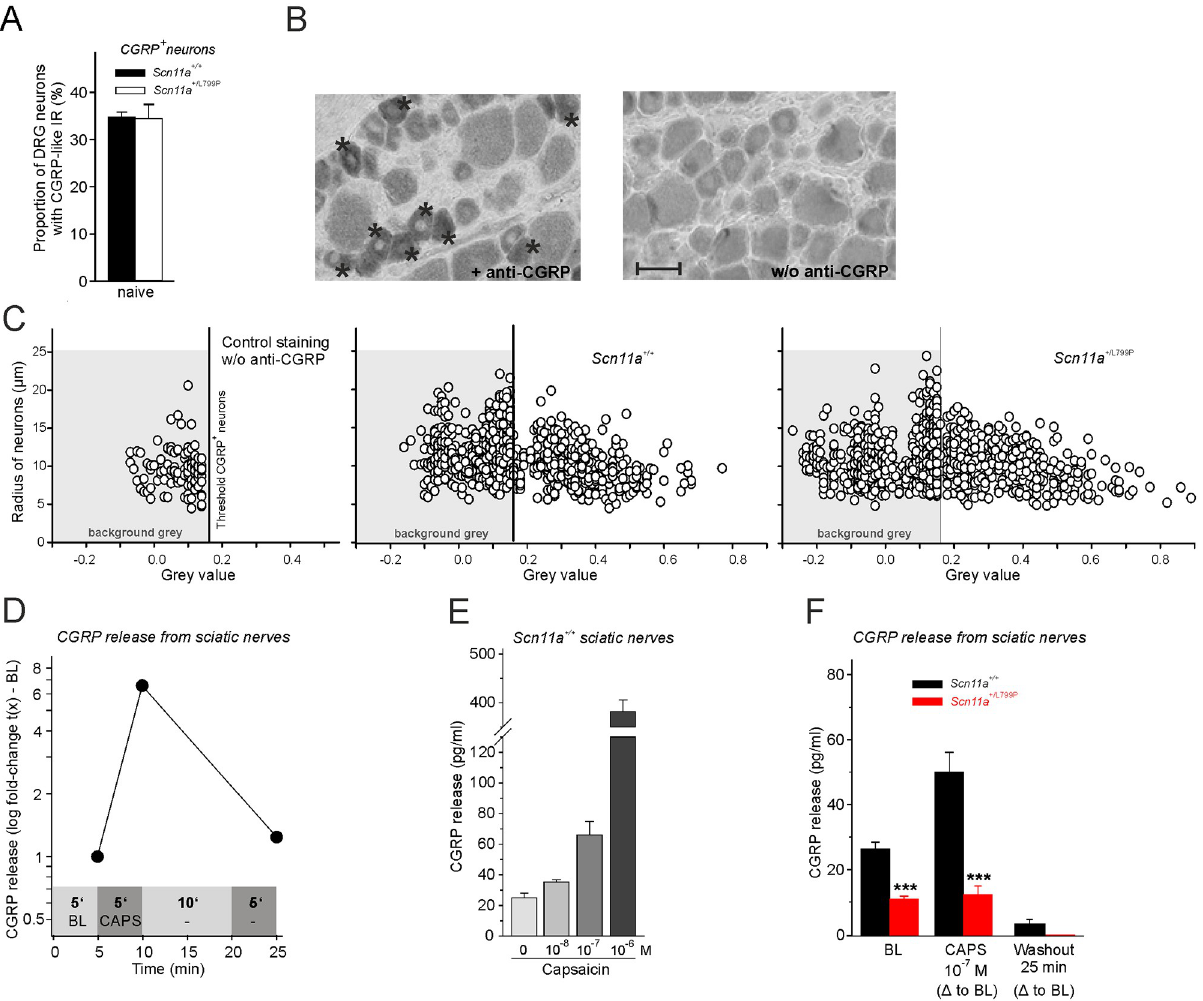
Fig 2. Localization of CGRP-immunoreactivity in lumbar DRG neurons and CGRP release from sciatic nerve axons of Scn11a +/+ and Scn11a +/L799P mice. (A) Proportions of DRG neurons with CGRP-like immunoreactivity in lumbar sections from Scn11a +/+ and Scn11a +/L799P mice (n = 5–7 mice per group). (B) Sections of lumbar DRGs. The left section contains CGRP-positive neurons (labeled by stars), the right section was processed without anti-CGRP antibody for control. (C) Display of all DRG neurons analyzed for CGRP-like immunoreactivity. Each neuron is defined by its radius and its grey value. Neurons in the left panel, not exposed to the anti CGRP antibody, show the background grey level. Neurons in the other panels were counted as CGRP-positive if they had grey values above background. (D) Protocol of CGRP release experiments from sciatic nerve axons. Values from one nerve of a Scn11a +/+ mouse with 10 − 7 M capsaicin are shown as an example. Areas in grey above the x-axis indicate the incubation time (in minutes) in the different test tubes. (E) CGRP release from sciatic nerve axons from na ï ve Scn11a +/+ mice without and after stimulation with different concentrations of capsaicin (n = 4–6 per concentration). (F) Scn11a +/L799P mice (3–7 months old) showed significantly less CGRP release from sciatic nerve axons in baseline (n = 14–21 nerves per group) and after stimulation with capsaicin (n = 8–11 nerves per group). Values are mean ± SEM. ��� p < 0.001. BL baseline, CAPS capsaicin, CGRP calcitonin gene-related peptide, Δ